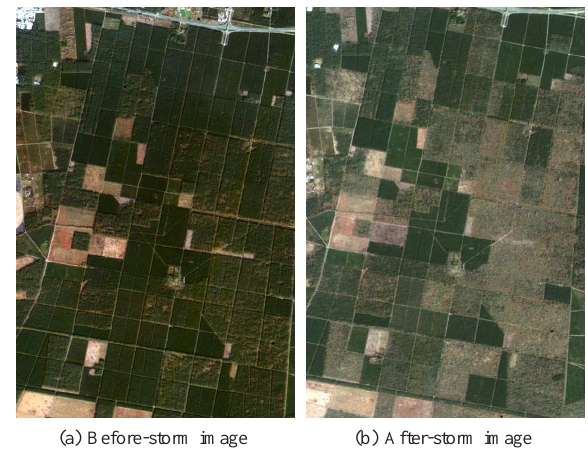
Figure 4: Formosat-2 multispectral images acquired before and after the Klaus